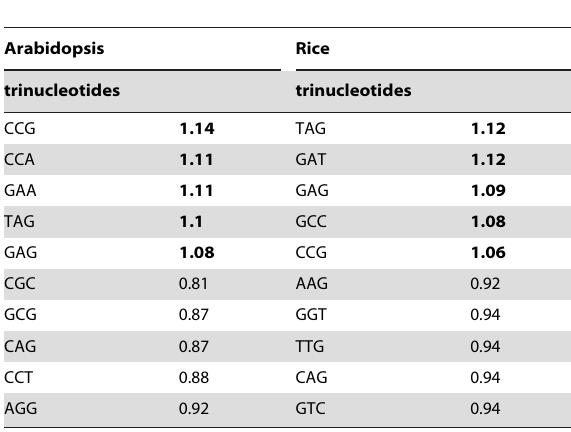
Table 5. Trinucleotide biases in introns of Arabidopsis and Oryza sativa .